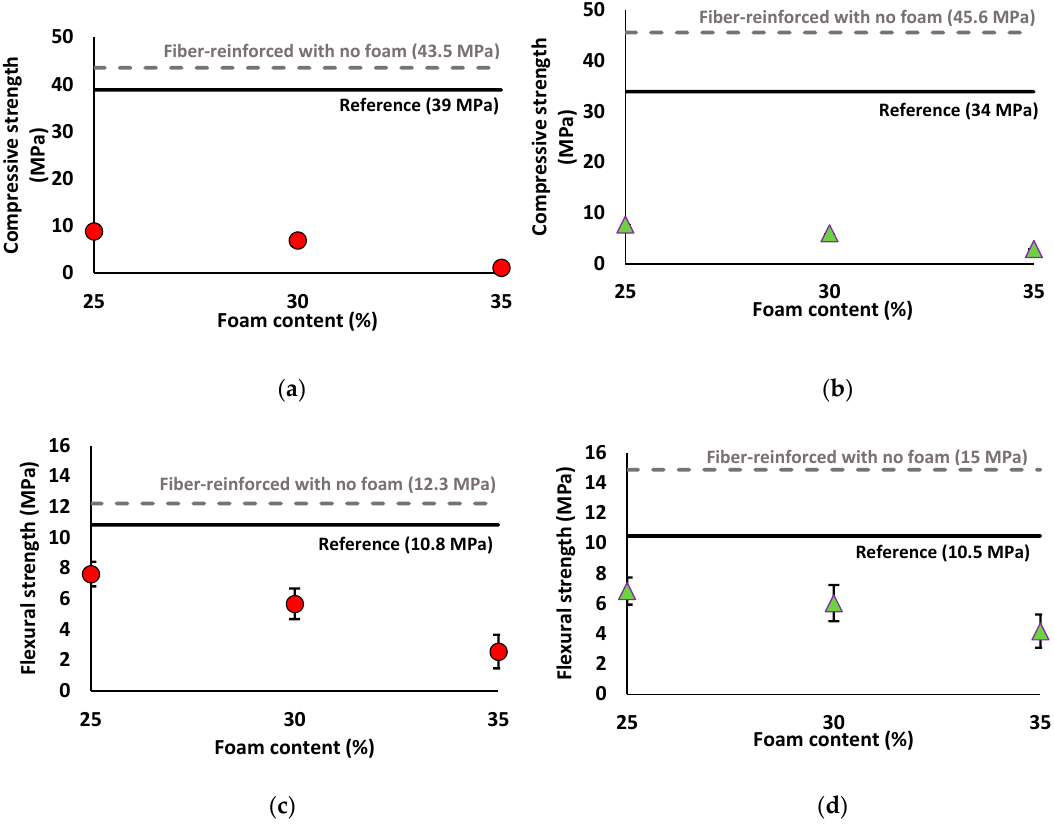
Figure 7. E ff ects of adding PP fibers and di ff erent foam content on the compressive strength of Figure 7. Effects of adding PP fibers and different foam content on the compressive strength of mix mix compositions: ( a ) SW50 / GW10; ( b ) SW30 / GW30; and flexural strength of mix compositions: ( c ) compositions: ( a ) SW50/GW10; ( b ) SW30/GW30; and flexural strength of mix compositions: ( c ) SW50 / GW10; ( d ) SW30 / SW50/GW10; (d) SW30/GW30.